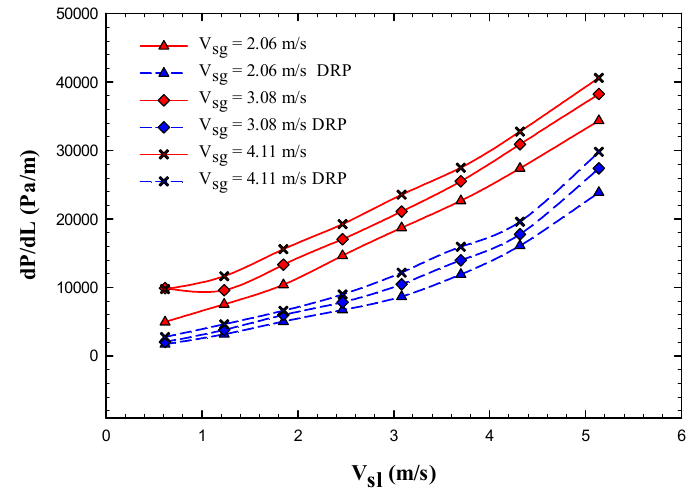
Figure 2. Comparison of the frictional pressure drop variation with respect to liquid superficial velocity at different gas superficial velocities of 2.06, 3.08 and 4.11 m/s.